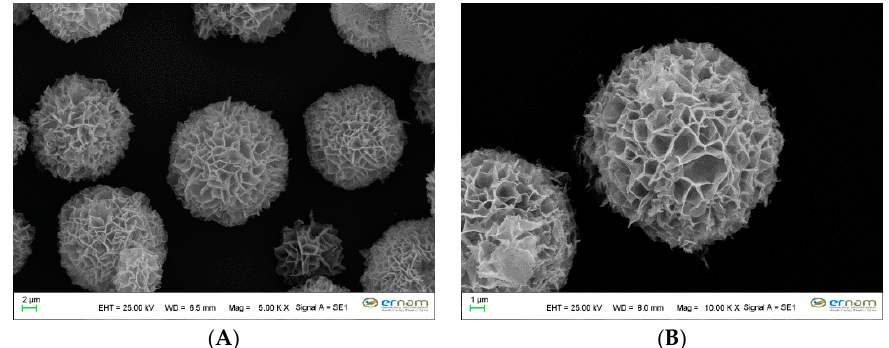
Figure 1. SEM images of hNFs synthesized at different incubation temperatures ( A ) +4 °C, ( B ) room